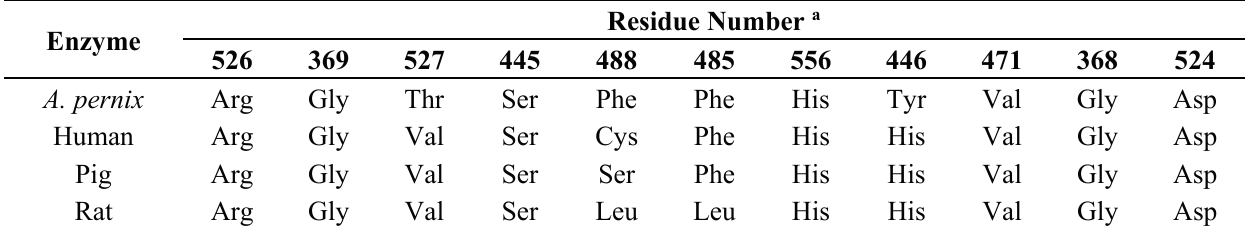
Figure 5. ( a ) chlorpyrifosmethyl oxon in the active pocket of APH; and ( b ) dichlorvos in the active pocket of APH drawn by LIGPLOT. Table 1. Sequence alignment of amino acids around Arg526 for major representatives of